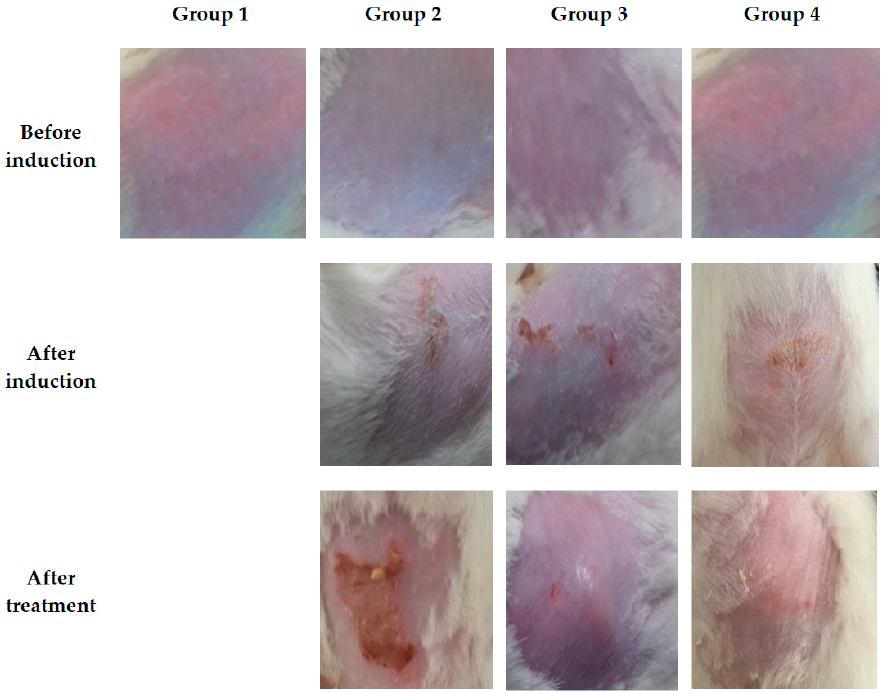
Figure 11. Skin samples of different rats before, after fungal infection using Candida albicans and after treatment. after